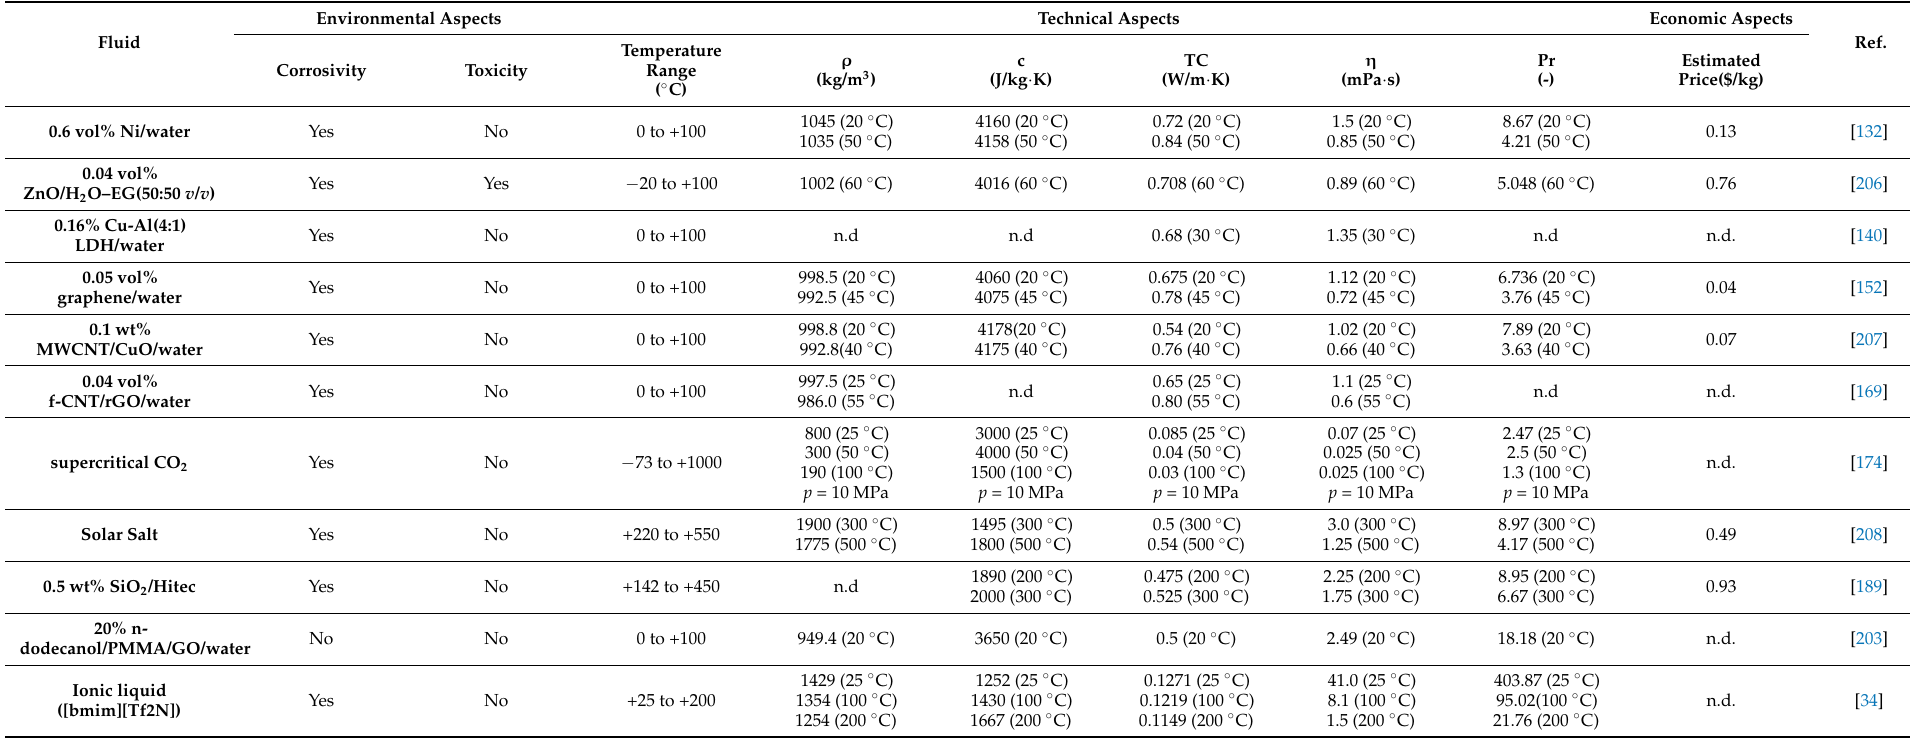
Table 2. Environmental, technical, and economic aspects comparison of examples of novel heat transfer